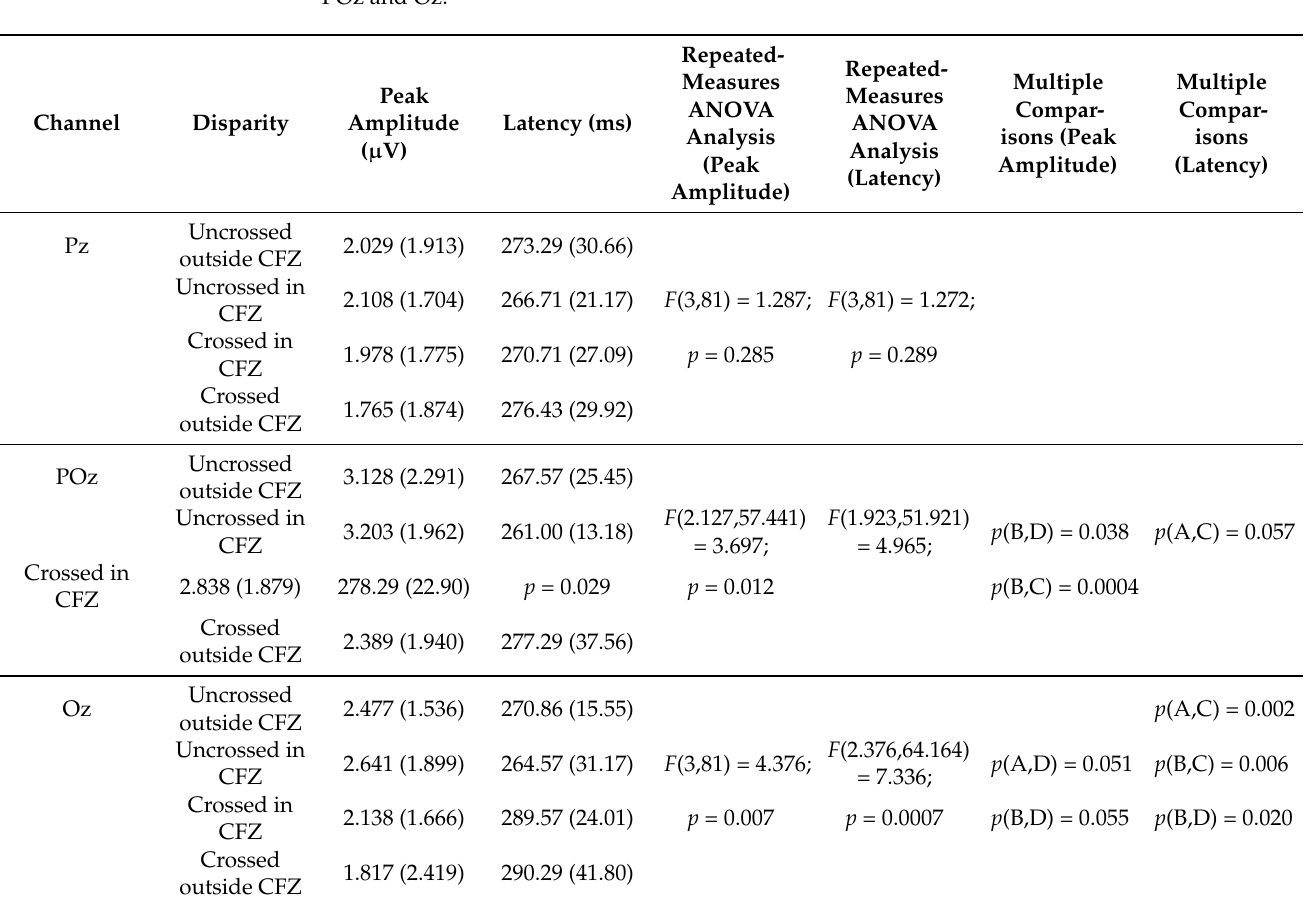
Table 2. Statistical results of component P2 characteristics with different disparities at channel Pz, POz and